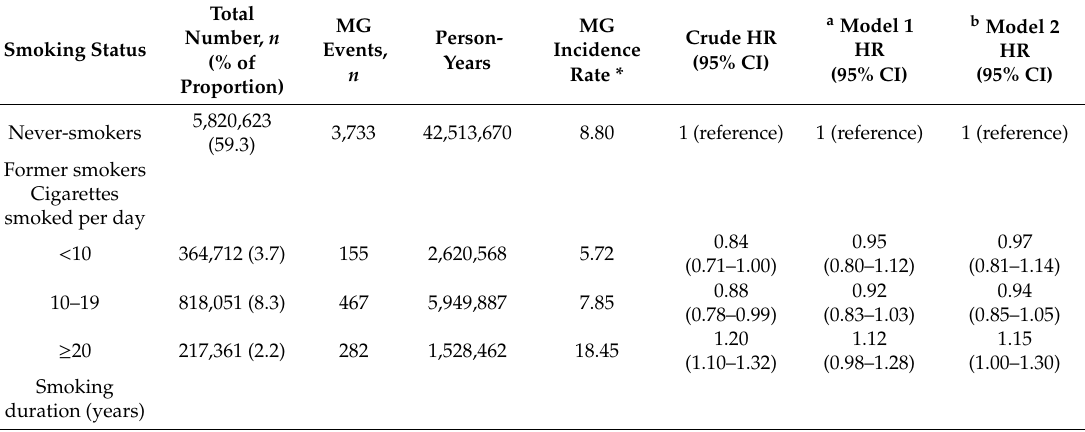
Table 3. Risk of developing malignant glioma according to smoking amount and